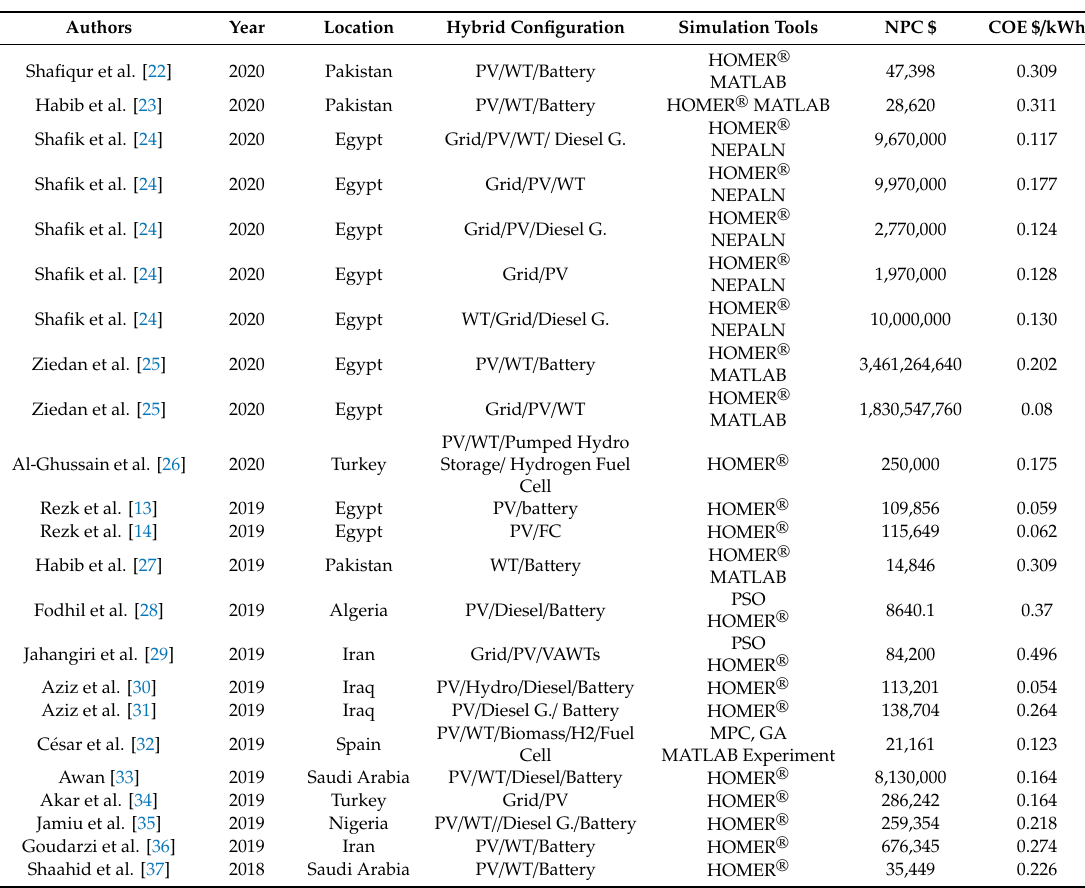
Table 1. Summary of literature review.